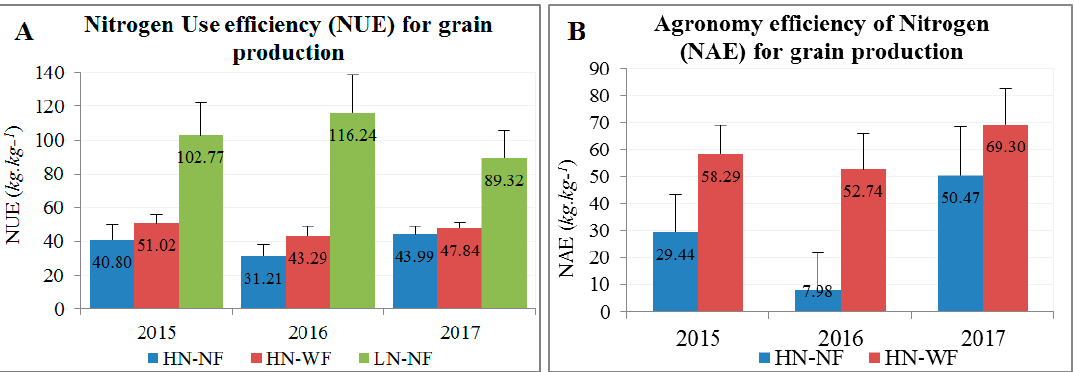
Figure 3. ( A ) Nitrogen use efficiency. ( B ) Agronomy efficiency of nitrogen in three years of trial.